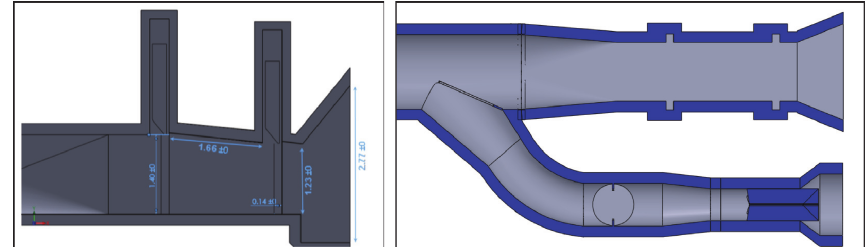
Figure 4: Details of construction of 3D geometry of Sardab Dam’s bottom outlet (all dimensions are in m).